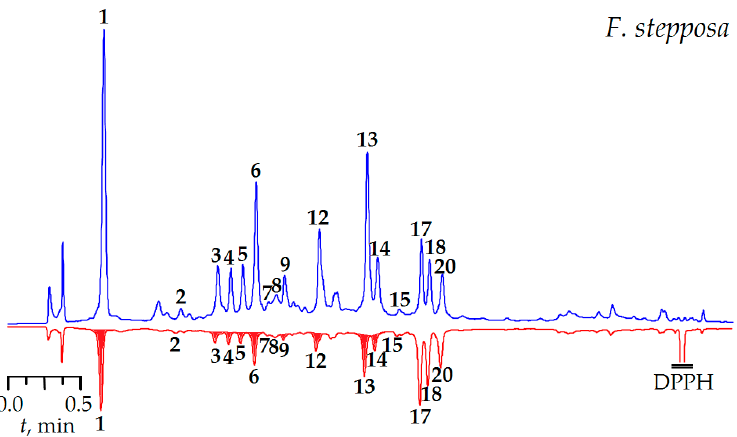
Figure 3. DPPH-MC-RP-HPLC-UV chromatograms of F. stepposa floral tea at 270 nm before